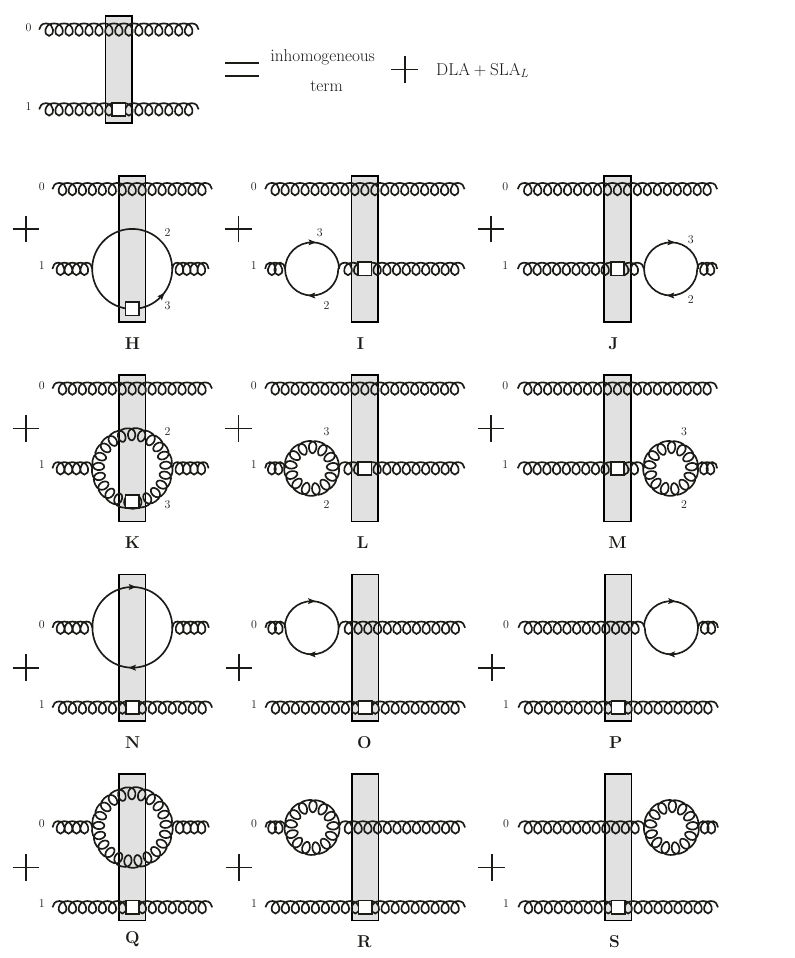
Figure 5 . Diagrams for SLA T splittings of a polarized adjoint dipole. For brevity, the initial condition and the DLA+SLA diagrams are L